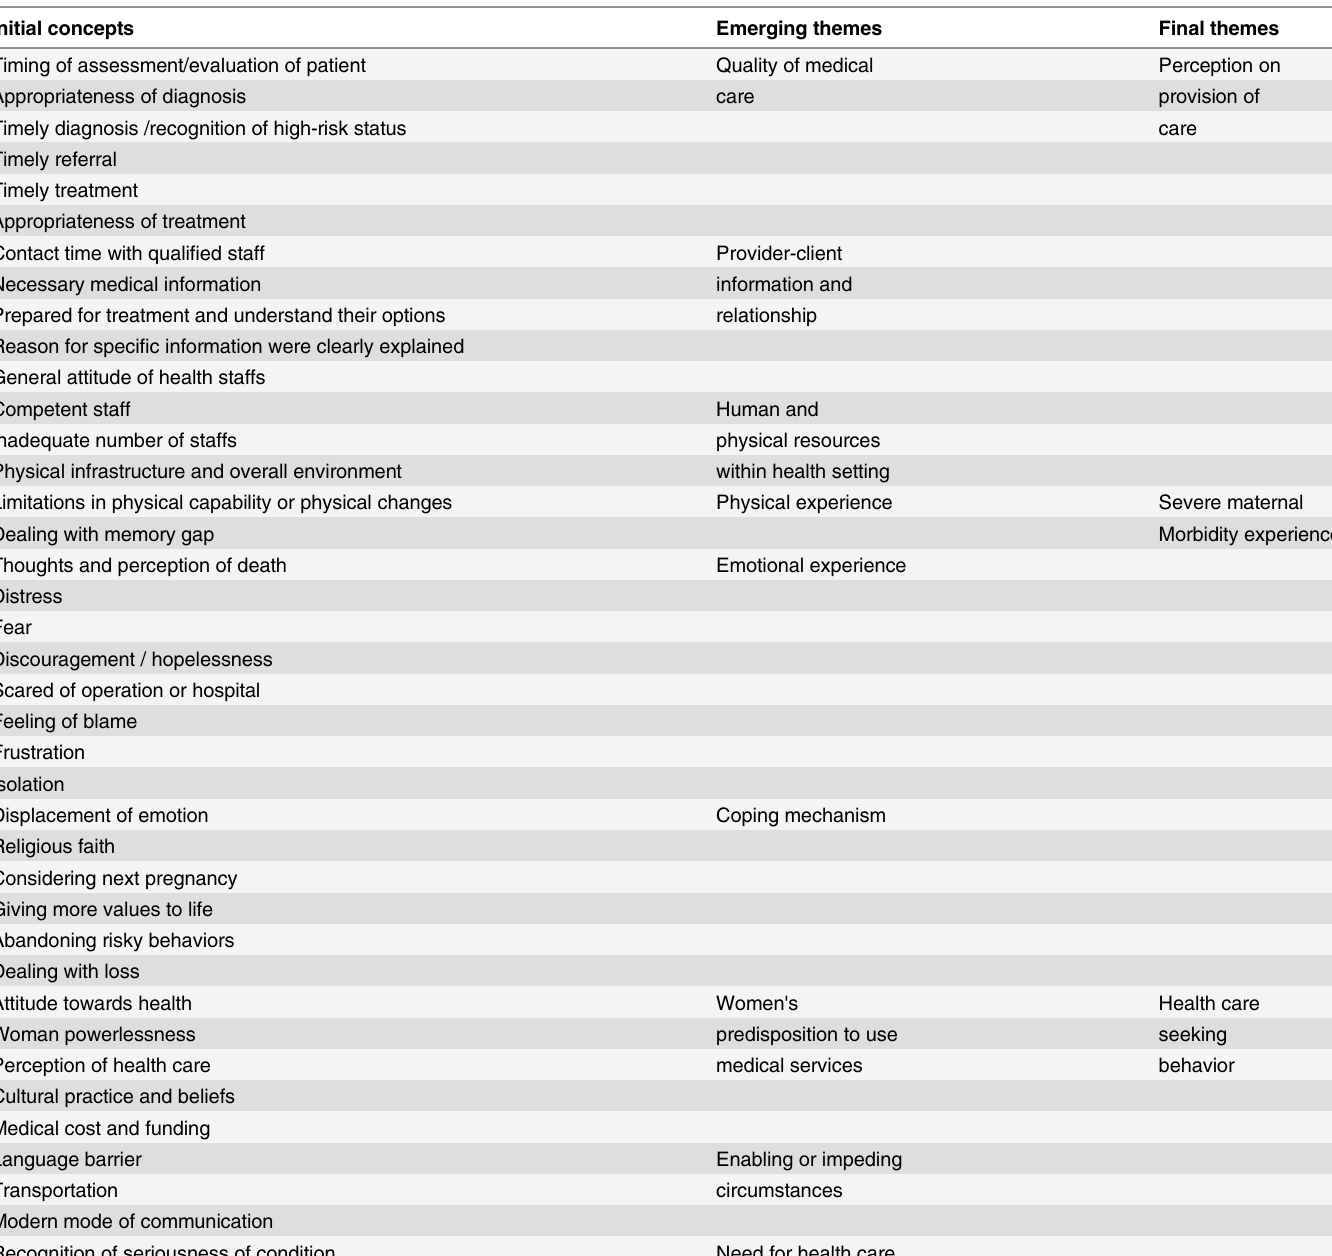
Table 2. Summary of concepts and